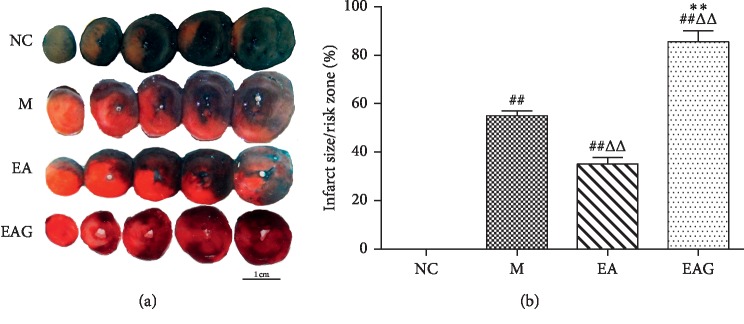
The typical photos of Evans blue-TTC double staining (a) and the statistical graph showing the myocardial infarct size as percentage of the risk zone in the different groups (b). (##P < 0.01, #P < 0.05, vs. NC group; ΔΔP < 0.01, ΔP < 0.05, vs. M group; ∗∗P < 0.01, ∗P < 0.05, vs. EA group, n = 4 in each group, χ¯±SE).